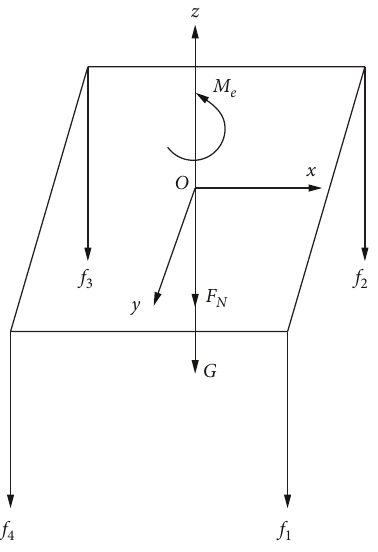
F IGURE 8: Schematic diagram of hanging basket.